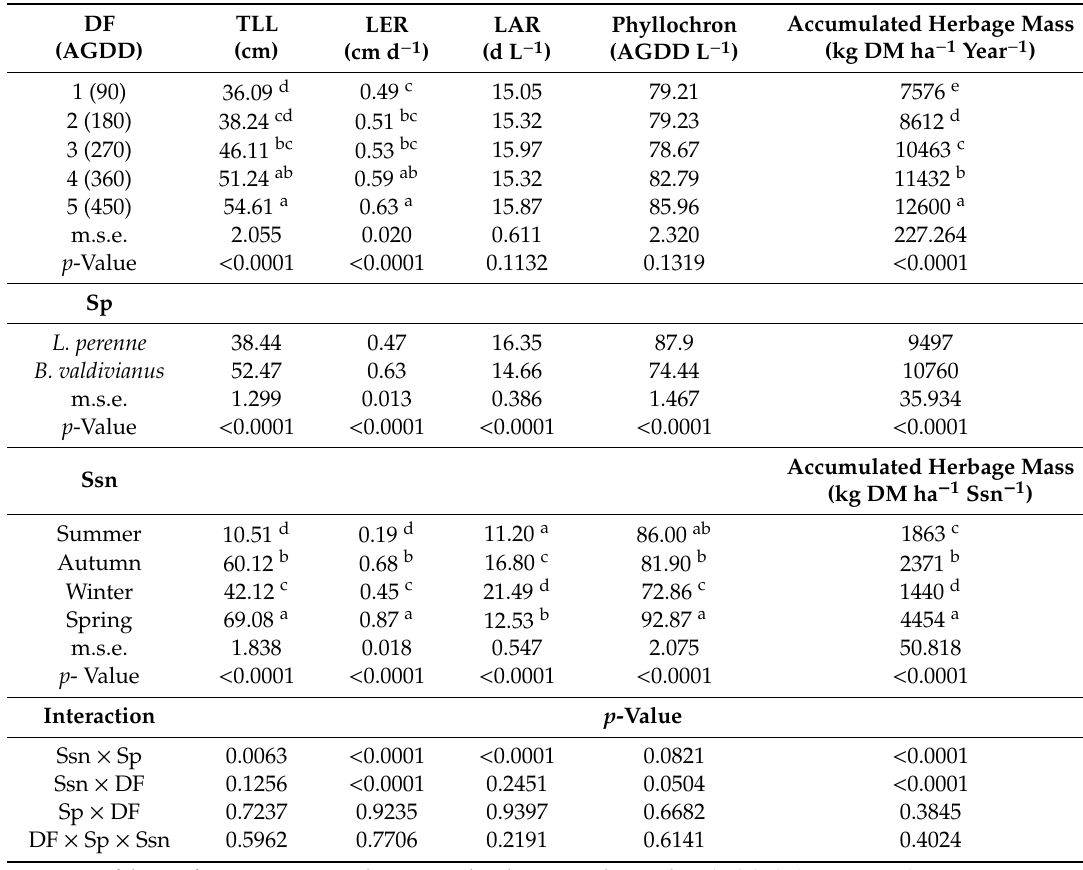
Table 1. Growth dynamics and accumulated herbage mass of two species ( Lolium perenne L. and Bromus valdivianus Phil.) as a ff ected by five defoliation frequencies and